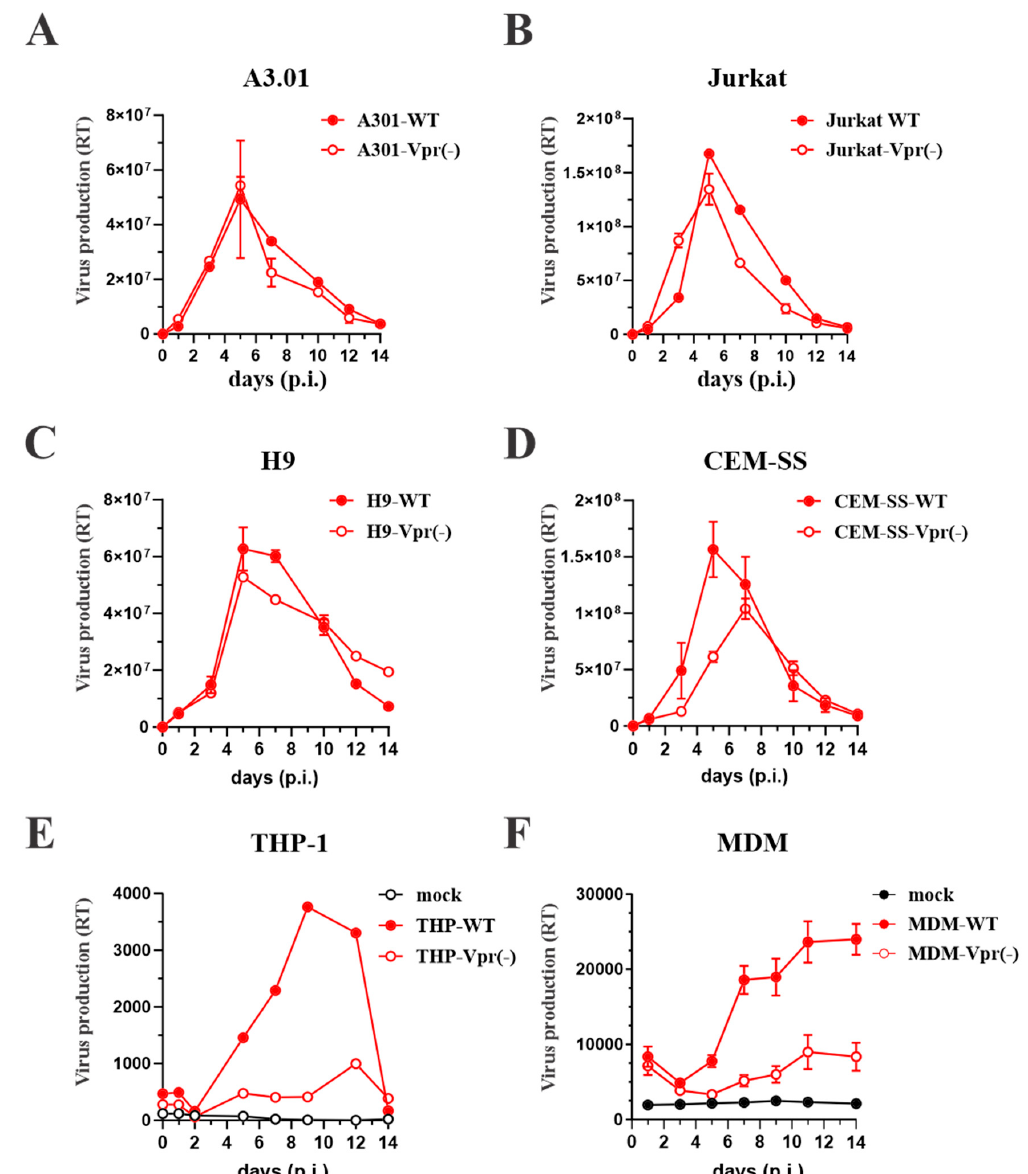
Figure 2. Replication of wild type (WT) and Vpr-defective (Vpr( − ) HIV-1 in various cell types. A3.01, Jurkat, H9, and CEM-SS are human CD4 + T cell lines that support the replication of X4-tropic HIV-1 (e.g., NL4-3). THP-1 is a human monocytic cell line and MDM are primary human